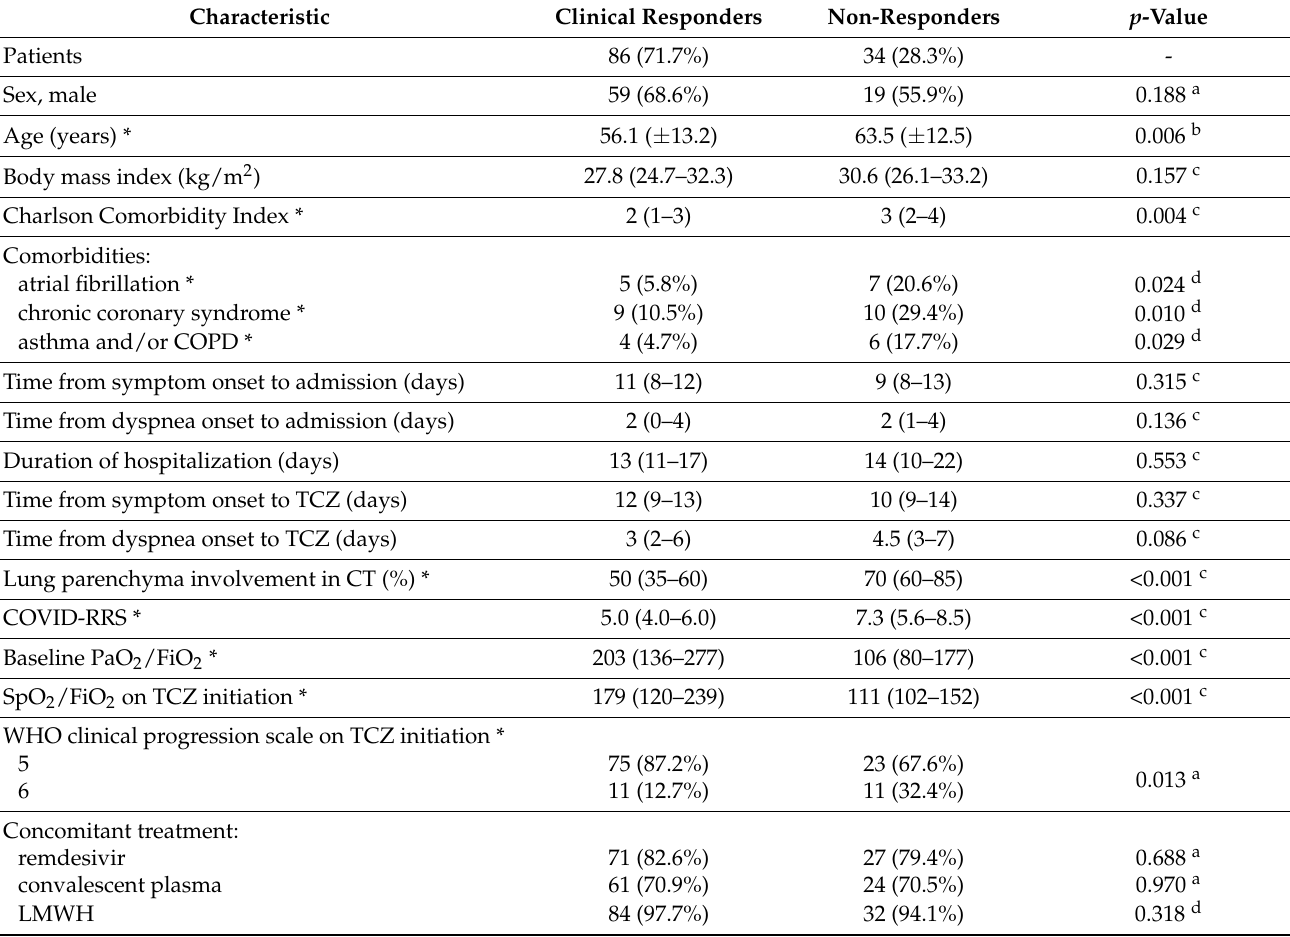
Table 1. Basic demographic and initial clinical characteristics of study group, presented as n (%), mean ( ± SD), or median